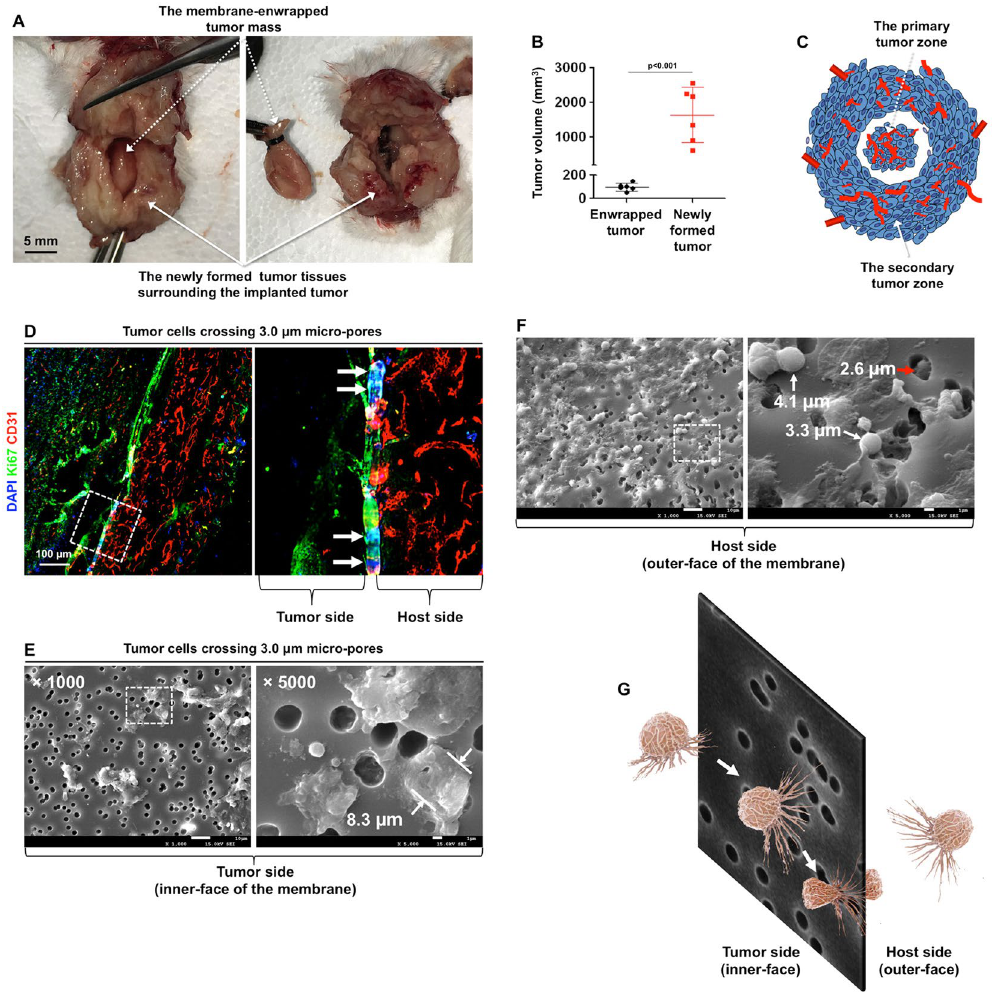
Figure 3. Cutting off tumor blood supply could not prevent local invasion of tumor. ( A ) The membrane- wrapped tumor was surrounded by newly formed tumor tissue 4 weeks after implantation. The dashed arrow indicates the implanted tumor. The solid arrow indicates the newly formed tumor tissue. ( B ) The volume of the original implanted-tumors and the adjacent tumor tissue was quantified using 6 mice. ( C ) The schematic shows that the newly formed tumor tissue surrounded the implanted primary tumor. ( D ) Three weeks after tumor implantation, the implanted tumors and the adjacent tissue were isolated and stained with CD31 (red), Ki67 (green), and DAPI (blue). The arrows indicate the cell nuclei crossing through the micro-pores of the membrane. ( E , F ) Electron microscopy shows the inner-face (tumor side) and outer-face (host side) of the 3.0 μ m membrane. Red arrows indicate the cells in the micro-pores. ( G ) The diagram shows that tumor cells cross the micro-pores via morphological